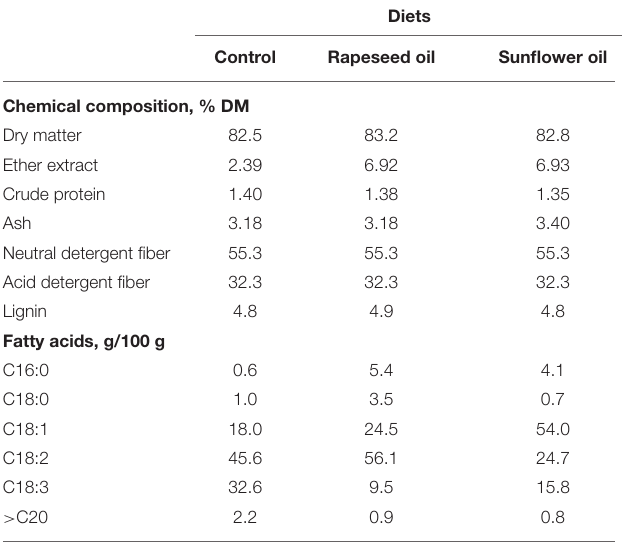
TABLE 1 | Diet and treatment